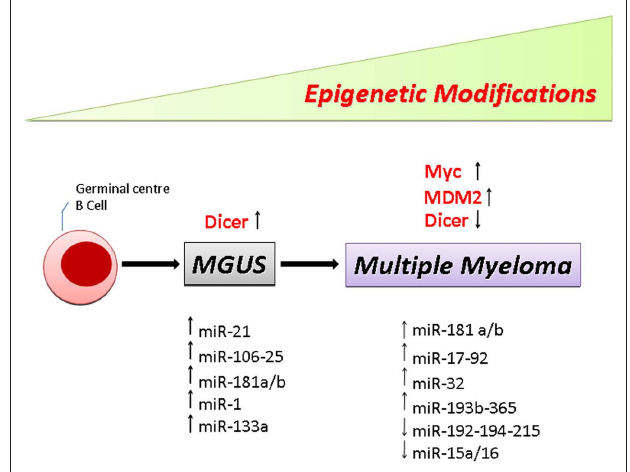
FiGuRe 1 | Schematic drawing showing the multistep molecular process of PC transformation. Representative list of the miRNAs and genes significantly deregulated in MGUS and MM patients versus